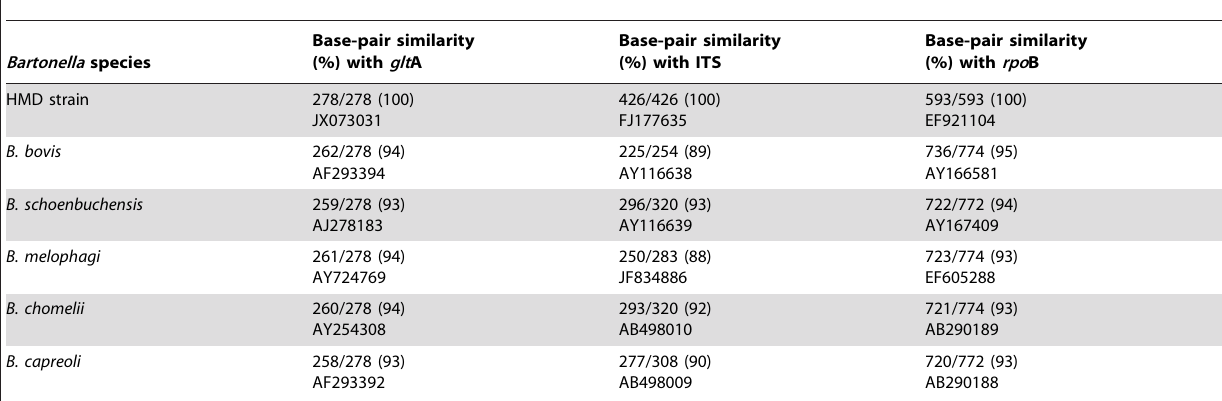
Table 4. Similarity between jackal strain F040 and closest Bartonella species for glt A, ITS and rpoB*.